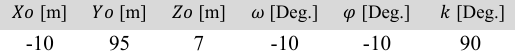
Table 6. Initial camera orientation parameters.